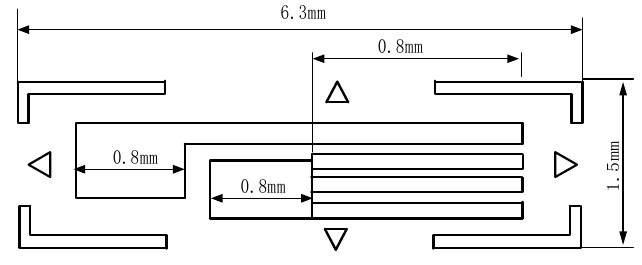
Figure 3. The size of the resistance strain gauge.